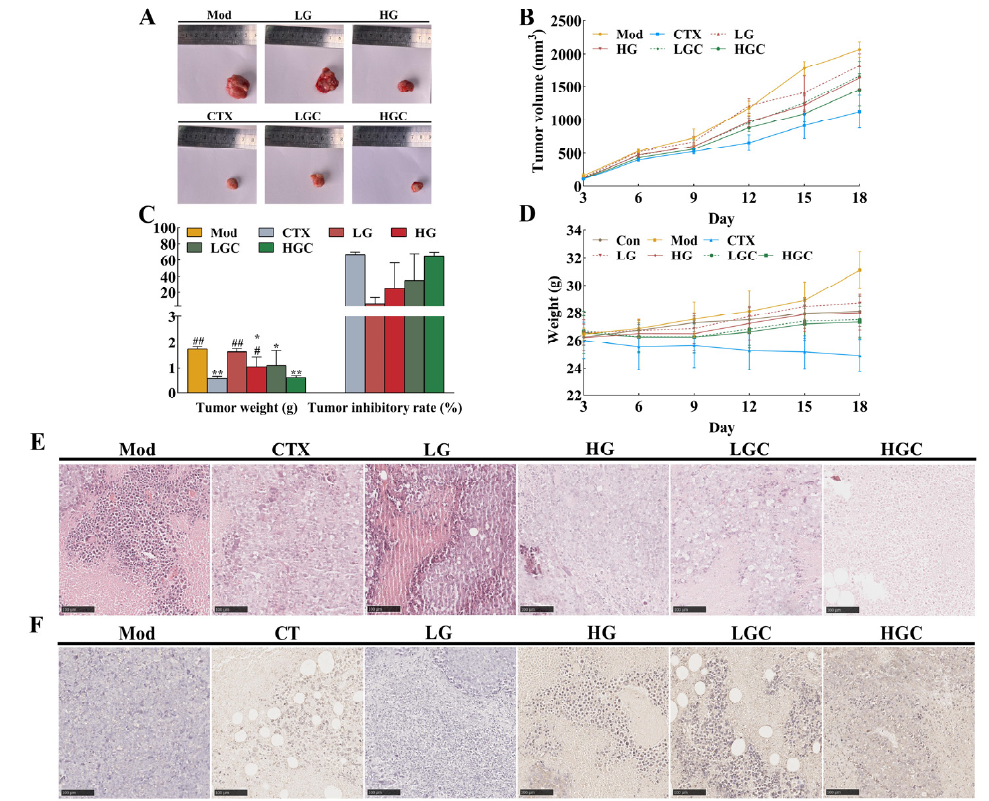
Figure 1. The inhibition effect of GFG combined with CTX on the H22 tumor-bearing mice. ( A ) Representative photos of tumors in the various groups. ( B ) Changes in tumor volume induced by different treatments. ( C ) Changes in tumor weight and tumor inhibition rate in the various groups. ( D ) Changes in body weight of mice in the various groups. ( E ) H&E staining and ( F ) TUNEL staining of the tumor samples in different groups. Data were expressed as the mean ± SD. * p < 0.05 and ** p < 0.01 versus the Mod group; # p < 0.05 and ## p < 0.01 versus the CTX group.